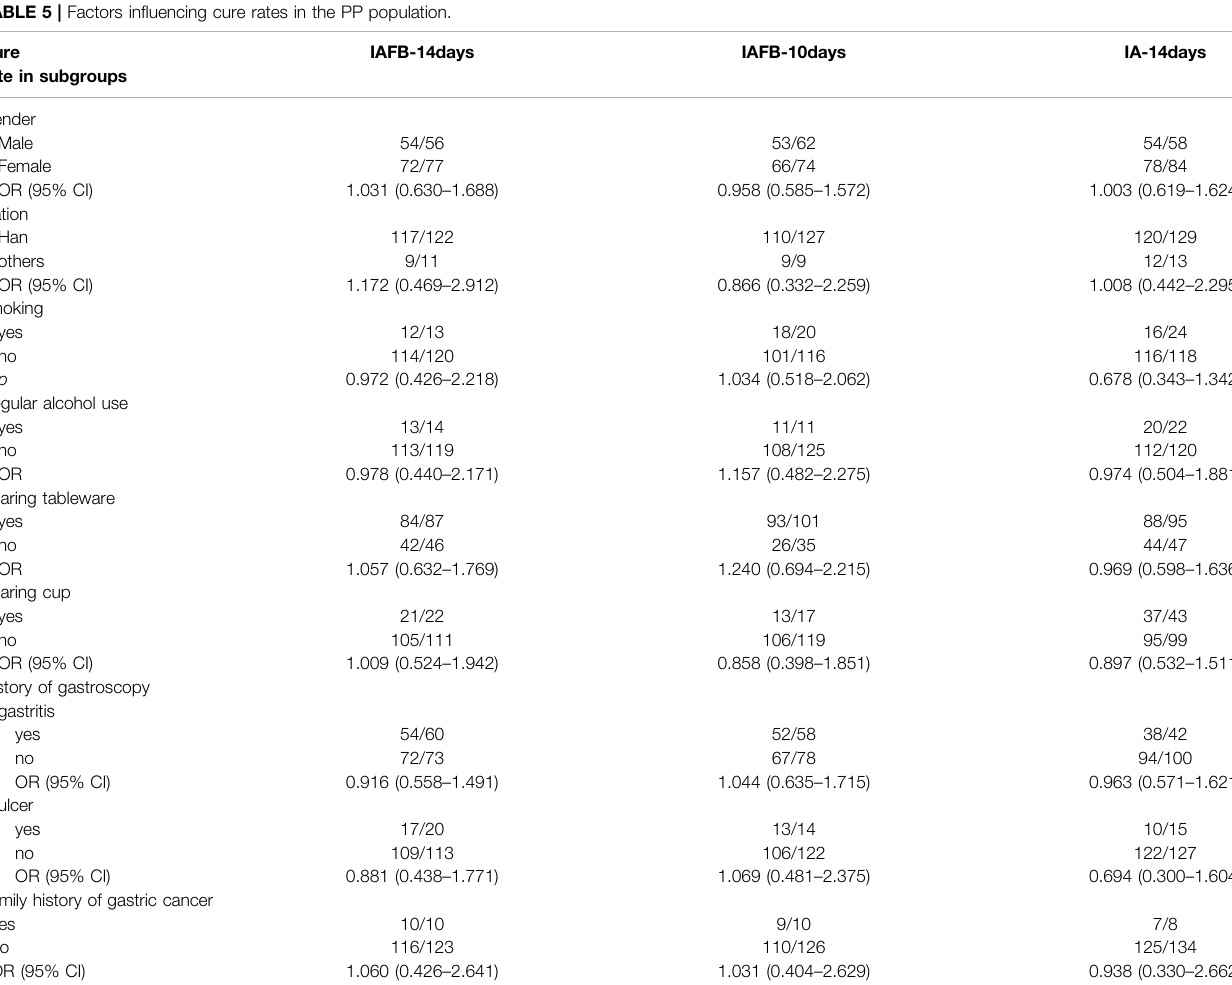
TABLE 5 | Factors in fl uencing cure rates in the PP